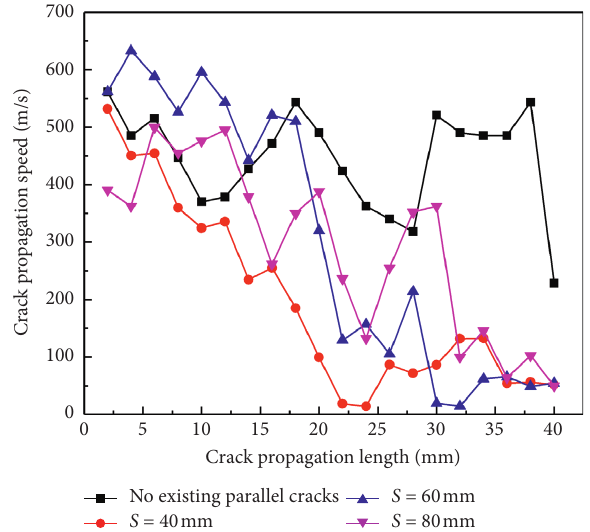
Figure 10: Crack propagation velocity versus crack extending distance.